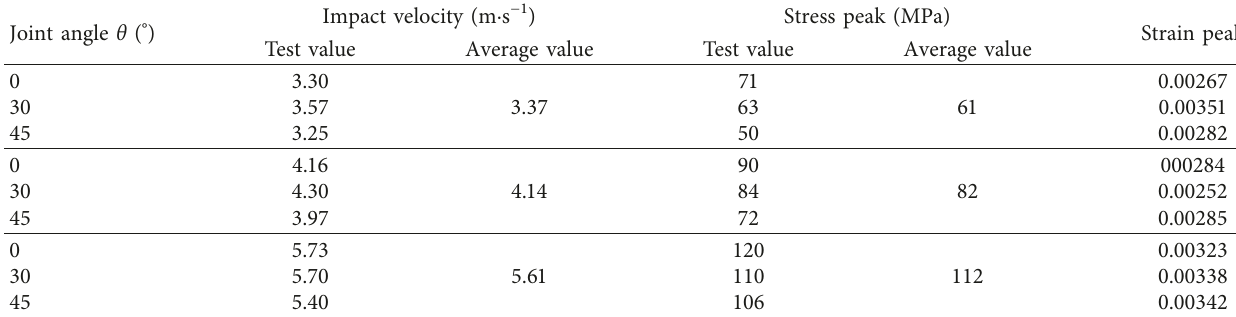
Table 2: Test results of test pieces under different joint